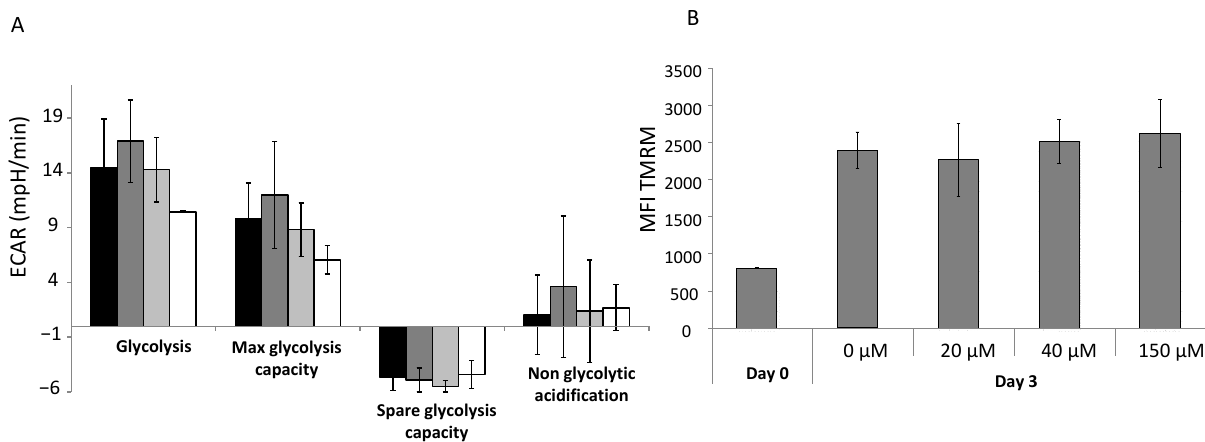
Figure 5. αTOA does not affect glycolysis or the mitochondrial activity of CD34 + cells in culture. ( A ) αTOA at physiological concentrations does not affect glycolysis (estimated on the basis of ECAR) after 3 days of culture, while the dose of 150 µM exhibits a decreasing trend of both ECAR and maximal glycolysis capacity ( n = 6). ( B ) Global mitochondrial activity (TMRM probes) is maintained after 3 days of culture, ( n = 3). Data are presented as means +/− SD. ECAR = Extracellular Acidification Rate; MFI = Mean Fluorescence Intensity; TMRM = TetraMethylRhodamine Methyl ester.